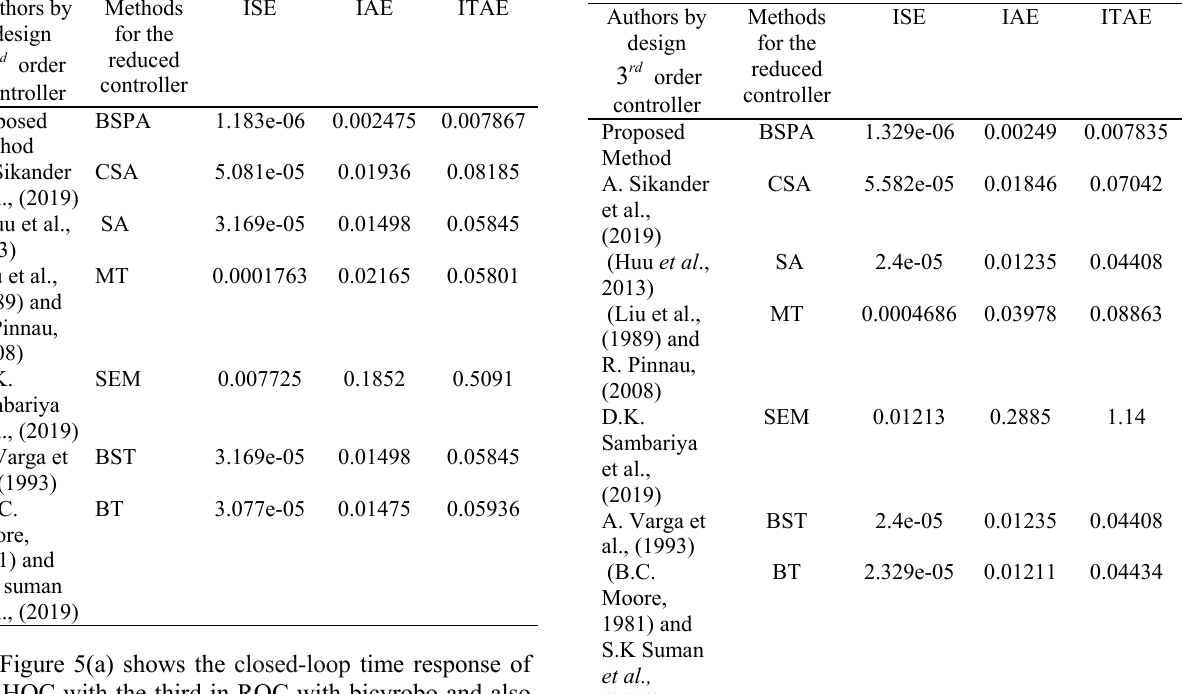
Table 6: Performance comparison of closed-loop bicyrobo using third order controllers with Case -1 Authors by design